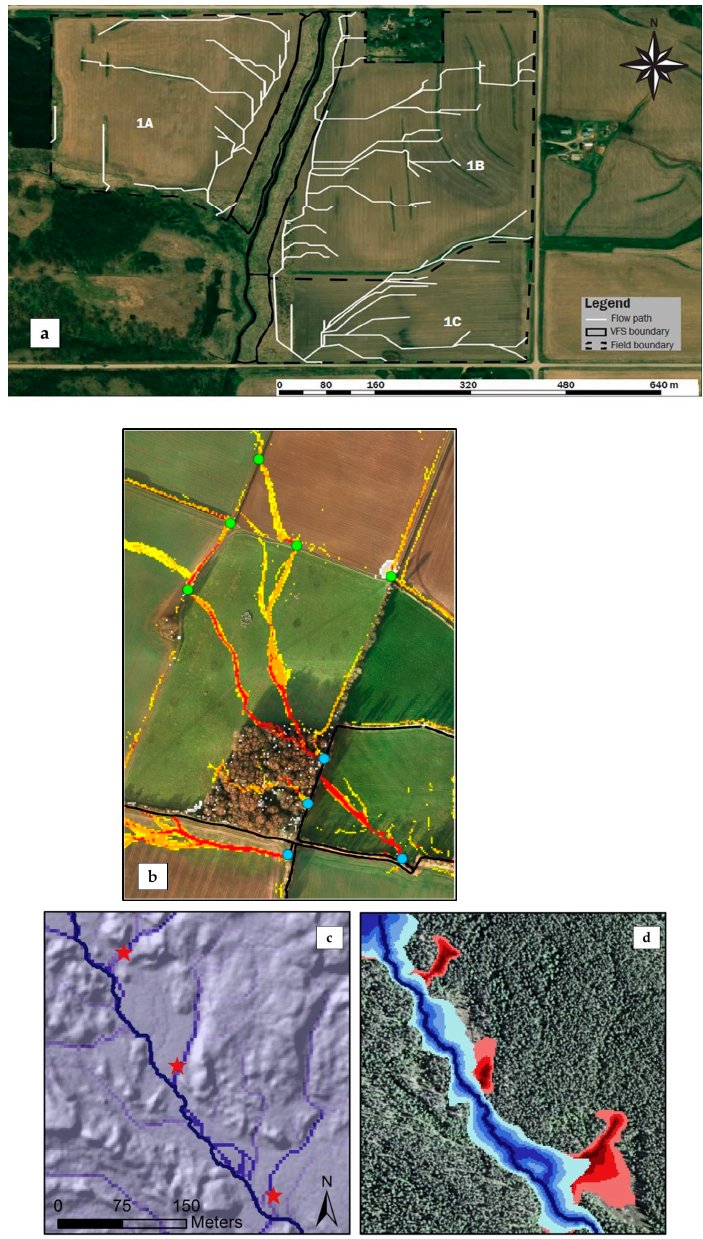
Figure 4. Model estimates of overland runoff flow (Q of ) pathways using light detection and ranging (LiDAR) based digital elevation models from Shrivastav et al. [84] ( a ) and Thomas et al. [71] ( b ) illustrating the tendency for non-uniform Q of , and highlights the critical importance of targeting riparian buffers at known O of delivery points to intercept sediment and phosphorus prior to reaching streams. Yellow and red in 4b indicate Q of areas and blue circles indicate Q of delivery points. Variable width riparian forest buffer zones predicted by a LiDAR based groundwater hydrology model by Kuglerov á et al. [82] ( c , d ). Panel 4c shows a sunlit LiDAR image of a stream section; blue lines are small streams and red stars are runoff collection points. In panel 4d, blue layers indicate model predicted groundwater discharge zones (darker blues indicate greater fluxes) and red areas are intermittent streams. All figures reproduced with